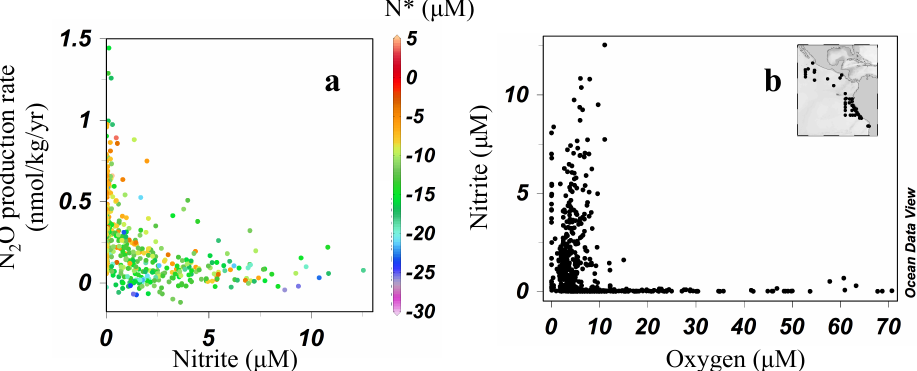
Fig. 7. (a) ETP N 2 O production rate (N 2 OPR) vs. NO −